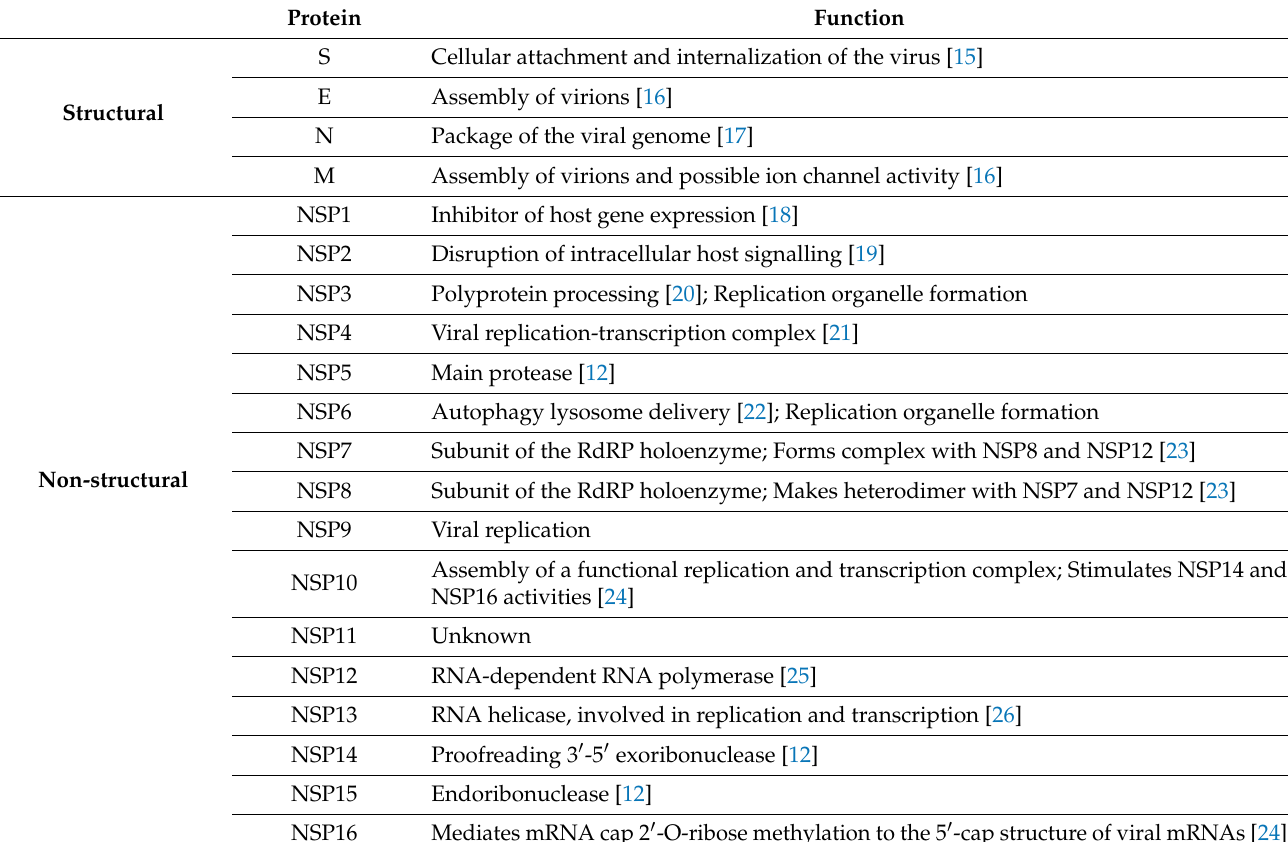
Table 1. Coronavirus structural and non-structural